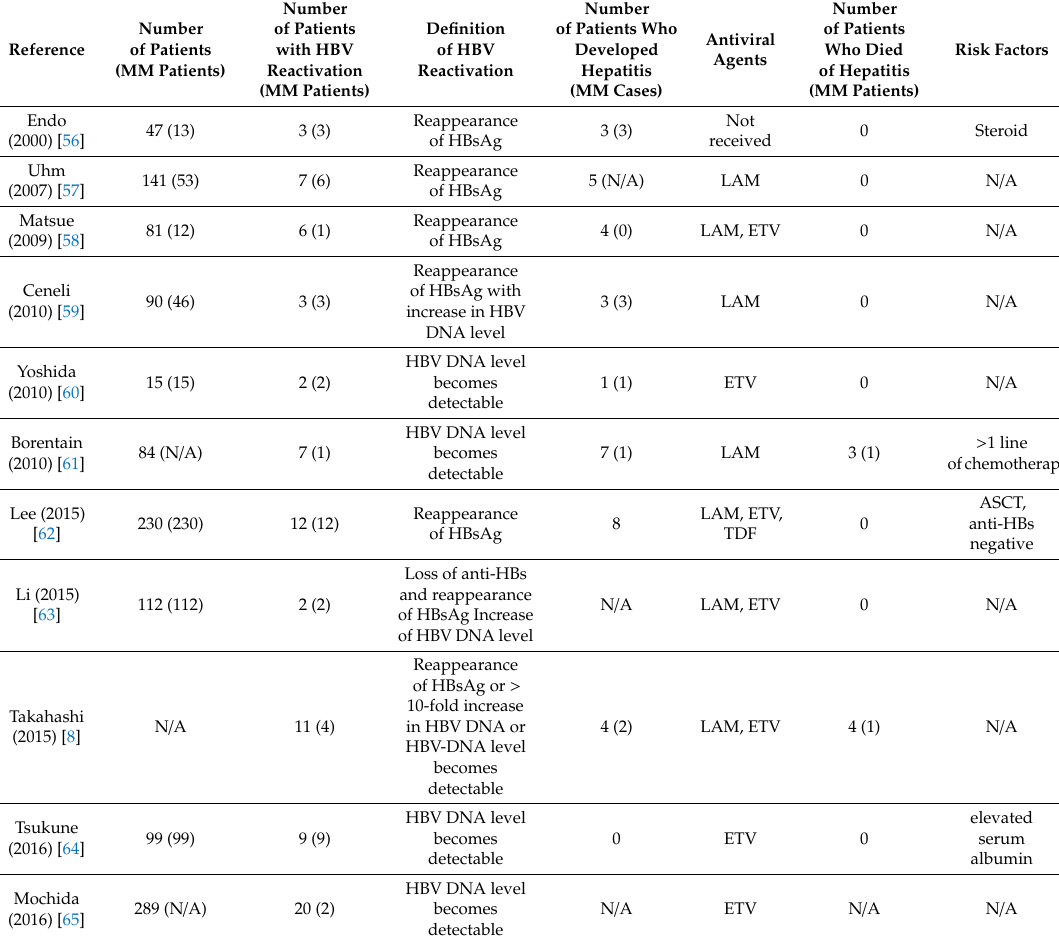
Table 5. HBV reactivation in MM patients (case